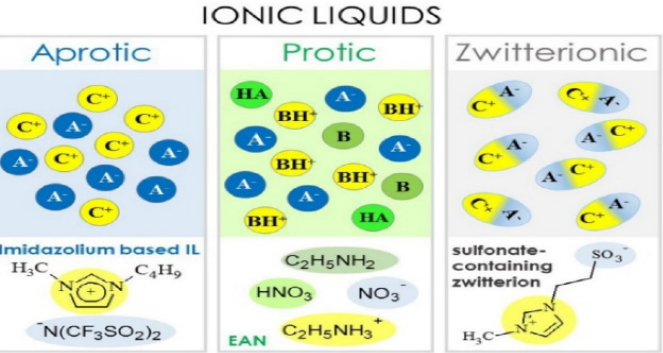
Figure 2. Classes of ionic liquids (aprotic, protic, and zwitterionic) (A − : anion, B: base, C + : cation, BH + : Brønsted base, HA − : Brønsted acid) [49].